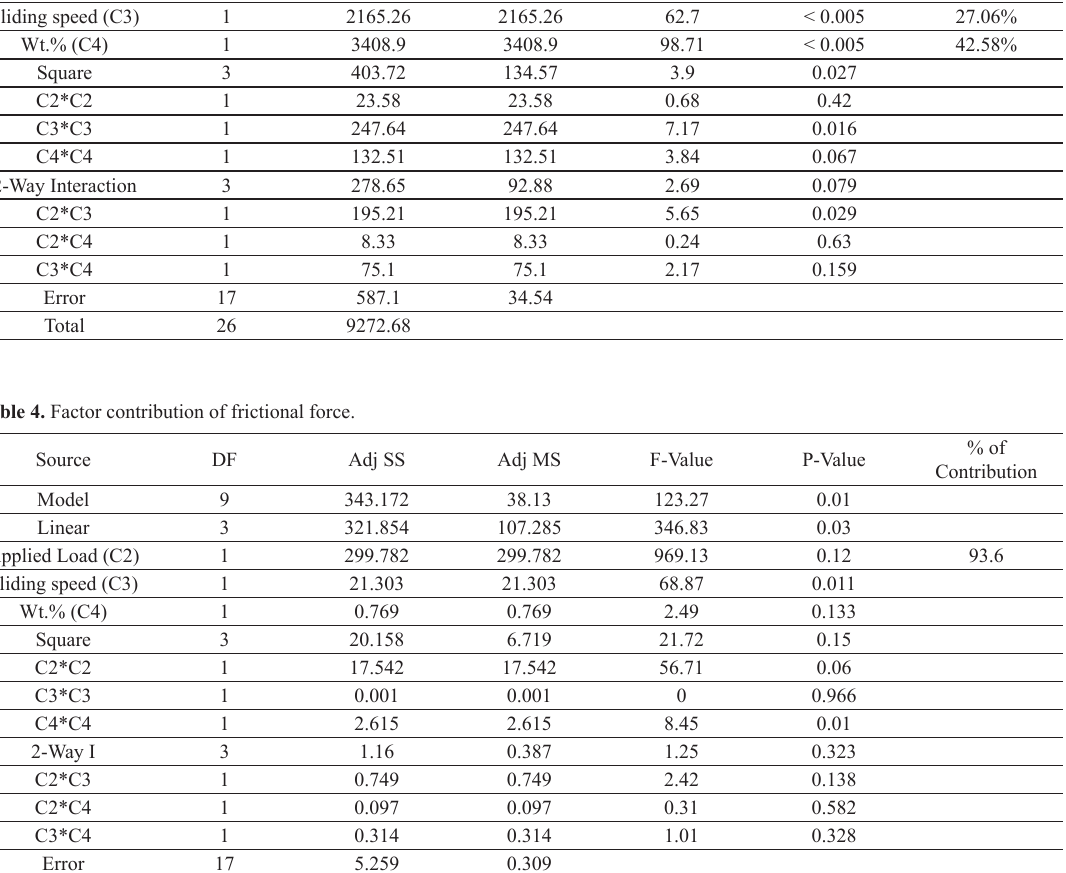
Figure 3a (stable state condition, applied load 30N; sliding distance of 1000m) shows the sliding direction and formation of wear debris on the rubbed surface of the Chromel – 6 wt.% TaC composites. Formation of debris was appeared due to the adhesion of TaC particle on the chromel alloy. Addition of 6% TaC improve the material at both high load and sliding velocity conditions. Figure 3b shows the worn out surface of SEM that indicates ploughing of material, which results in more removal of material. This occurs due to enormous plastic deformation and subsurface cracking 28 . As a result of ploughing, more pullout of material takes place. Figure 3c shows the formation of grooves, due to the transformation of nucleation crack into the fracture 29 . The wear rate of the composite depends on the amount of reinforcement particles 30 . The optimal coefficient of friction and grain refinement was analyzed in magnesium alloy 31 . The tribological behaviors were enhanced through laser treatment of the material surface 32 .